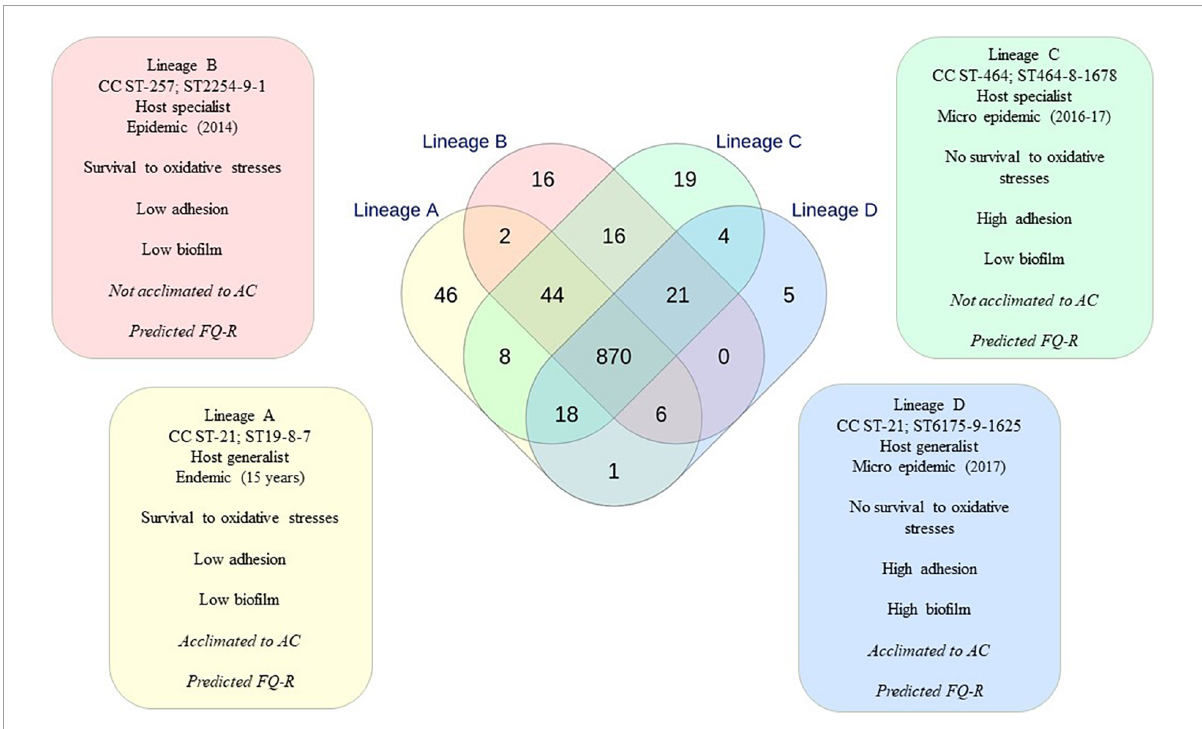
FIGURE6 Metaphenotypical profile linked to each recurrent genomic lineage and the number of specific targets related to them. Relationships between the loci identified in the four lineages and specific targets were obtained from the Venn diagram performed previously using wgMLST INNUENDO typing scheme ( Figure 3 , Nennig et al., 2021). Phenotypes about AAC are mentioned in italic, as they need to be consolidated. Phenotypes about fluoroquinolone resistance (FQ-R) are mentioned in italic, as they are only in silico predictions. Factors identified as potentially linked to the phenotypical responses are listed in a colored